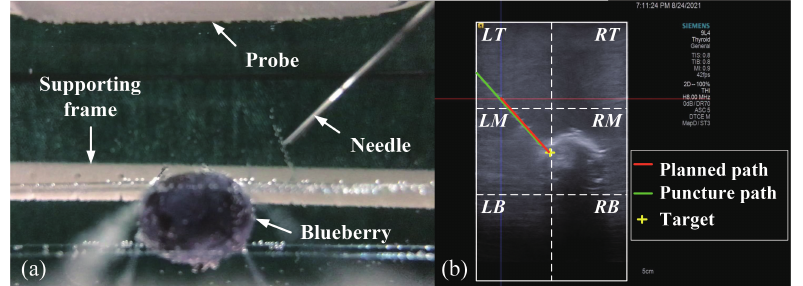
Figure 10. A schematic illustration of the setup for the blueberry biopsy experiments ( a ) and a schematic view of the partition of the water tank ( b ).